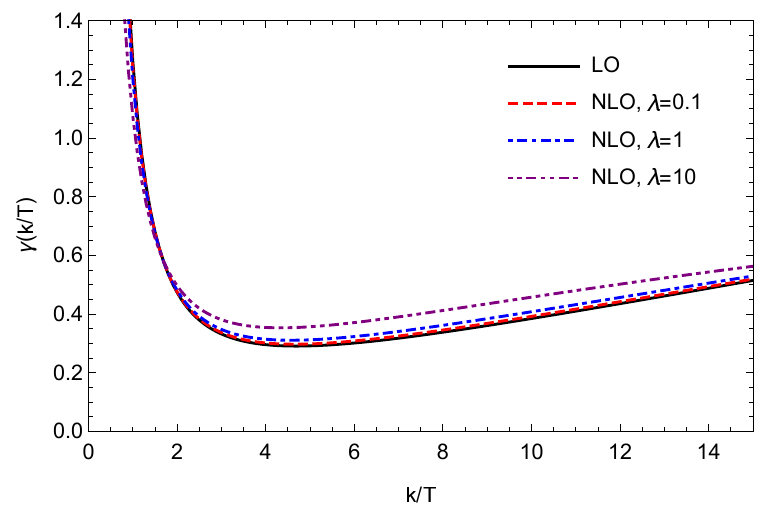
Figure 11 . The collinear photon rate in = 4 SYM. We plot the LO results [9] in solid black and N the NLO results at different couplings in various colors and dashing